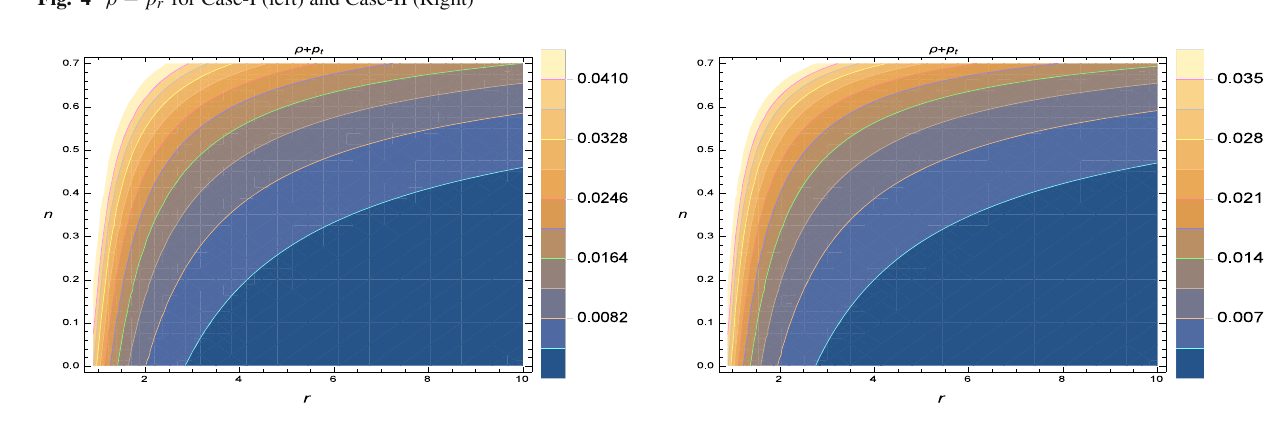
Fig. 5 ρ + p t for Case-I (left) and Case-II (Right)